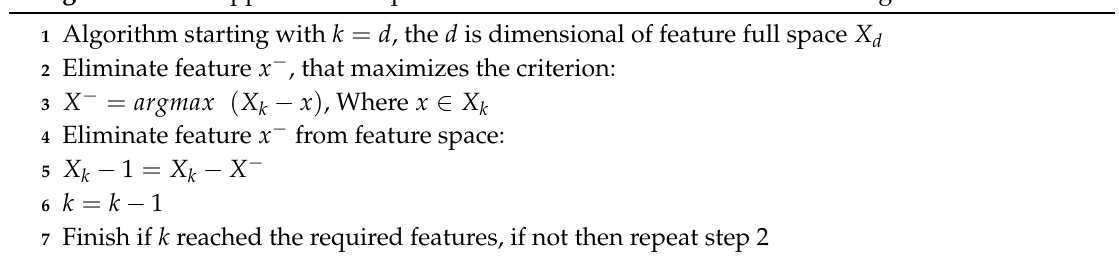
Algorithm 4: Wrapper based Sequential Backward Selection of Feature FS